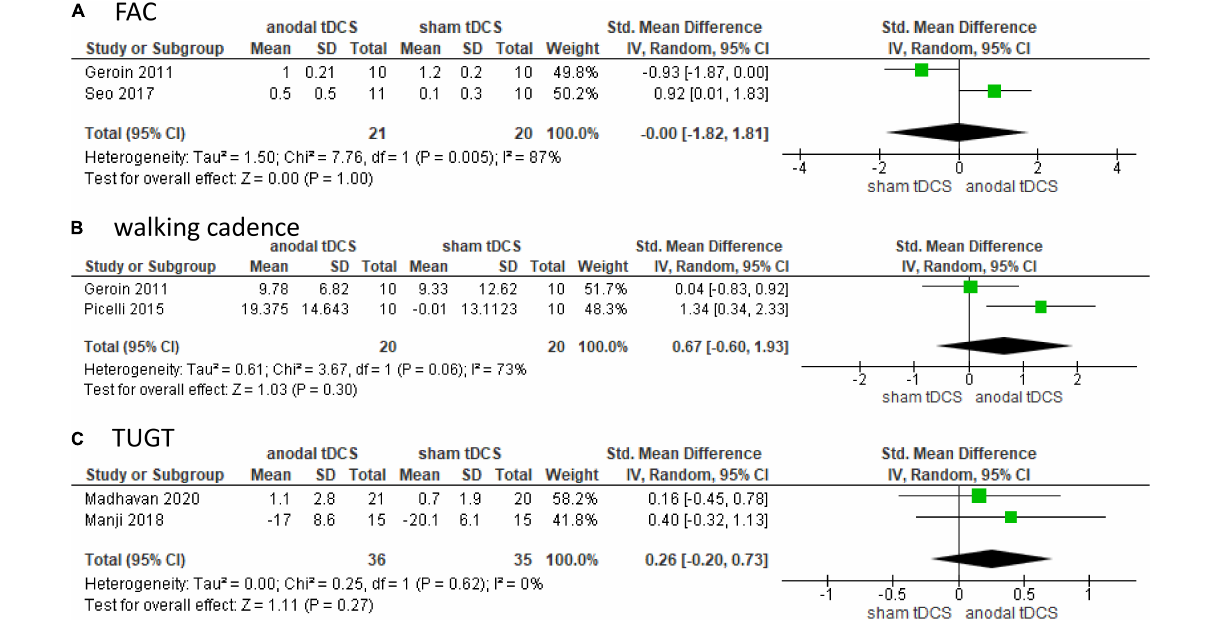
FIGURE 3 | Forrest plot displaying the standardized mean differences (SMD) between anodal and sham tDCSs. (A) Functional Ambulatory Category (FAC). (B) Walking cadence. (C) Timed up and go test